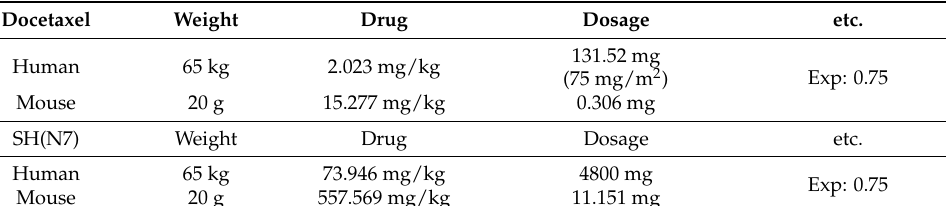
Table 2. Information of human equivalent dose. Animal equivalent dose was calculated using the following equation: human equivalent dose (mg/kg) = animal dose (mg/kg) × (weight animal [kg]/weight human [kg]) (1 − 0.75) . The exponent for body surface 0.75 was considered based on the Kleiber’s law. Docetaxel Weight Drug Dosage etc.